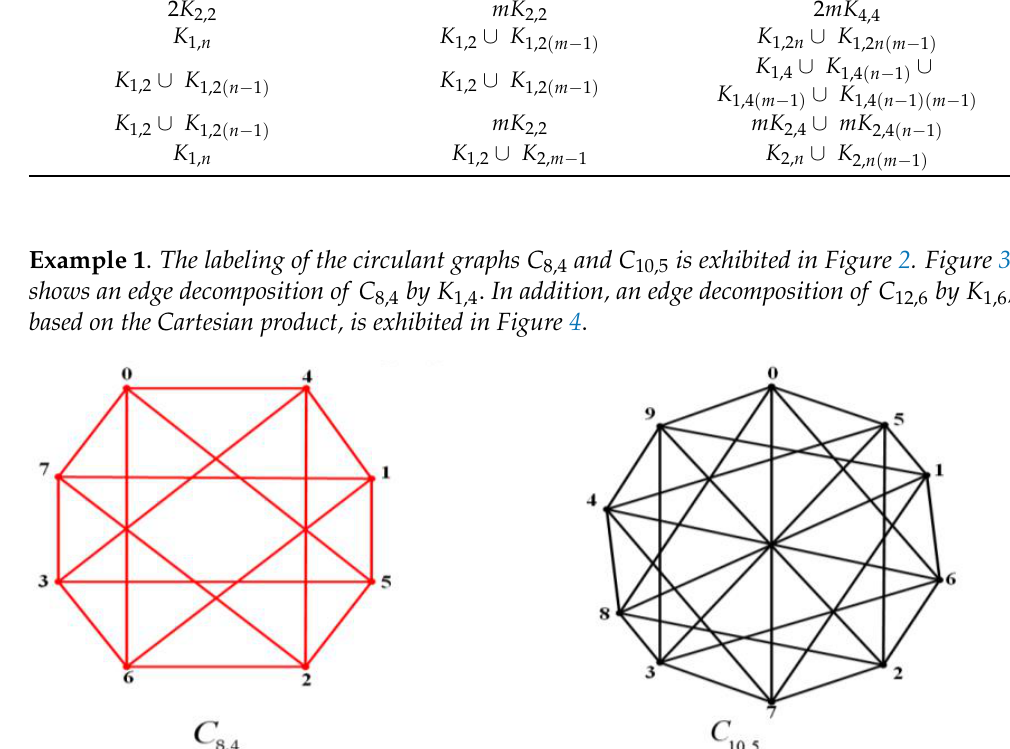
Table 1. Summary of results of Section 3.